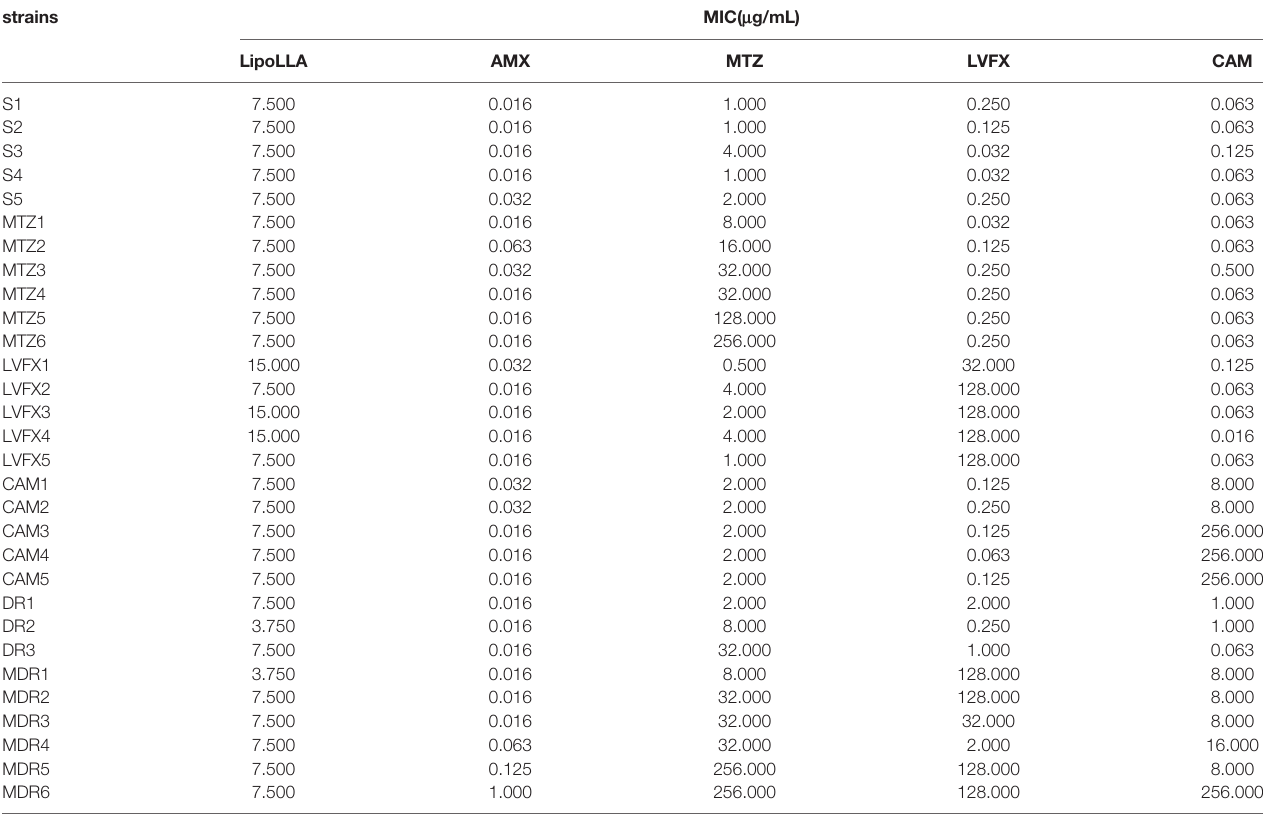
TABLE 1 | MICs of LipoLLA, AMX, MTZ, LVFX and CAM against H. pylori strains.